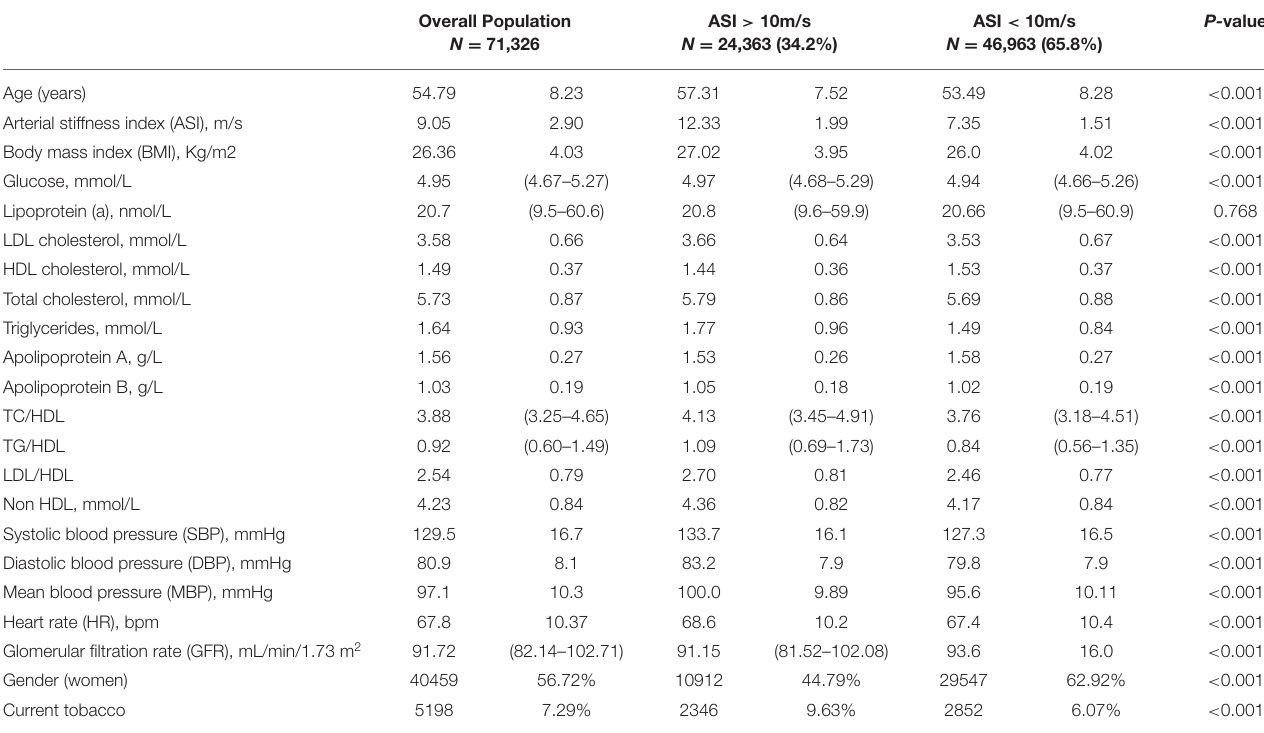
TABLE 1 | Characteristics of the study population.